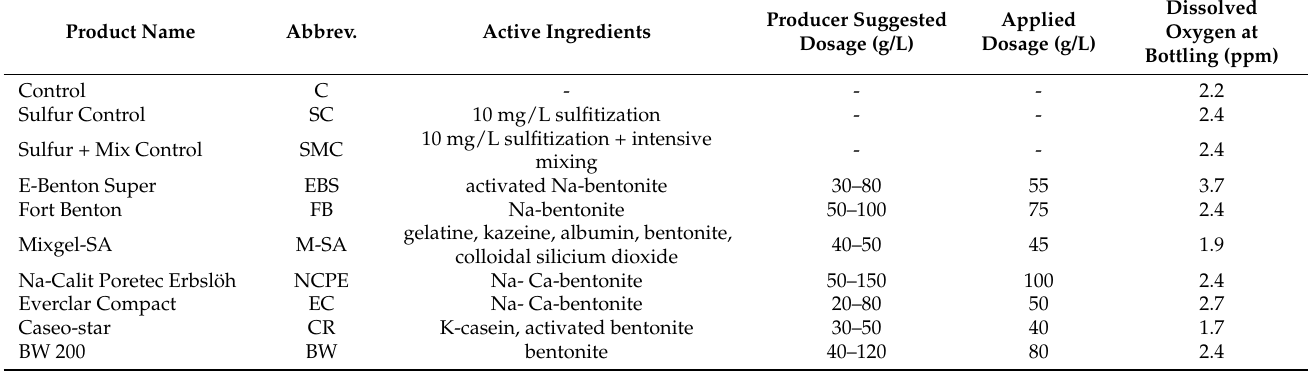
Table 1. Abbreviation, active ingredients, producer suggested dosage, applied dosage and dissolved oxygen at bottling of the bentonite products in order to evaluate white wine from Debrecen-Pallag, Hungary. Manufacturers, town and country of the applied products are Perdomini-IOC S.p.a., San Martino, Italy for E-Benton Super, Mixgel-SA, Caseo-star, ALFA-P, Bentamin-100, Pentagel, Bentonite- Compact Due and E-Benton Extra; Ever s.r.l., Venezia, Italy for Fort Benton, Everclar Compact, Everclar Beta, Nucleobent, Everclar Omega, Everclar Gamma and Benton flash; Erbslöh Geisenheim Gmbh, Geisenheim, Germany for Na-Calit Poretec Erbslöh and Granubent Pore-Tec; Süd-Chemie Verwaltungs GmbH, München, Germany for BW